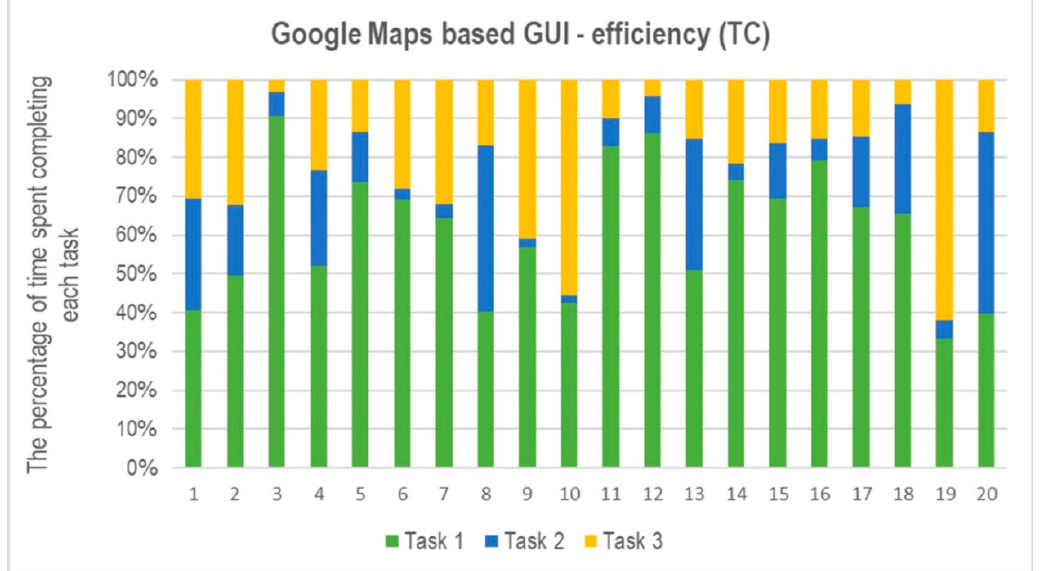
Figure 5. The percentage of time needed for completing tasks (TC) by each participant on Google Maps-based GUI.